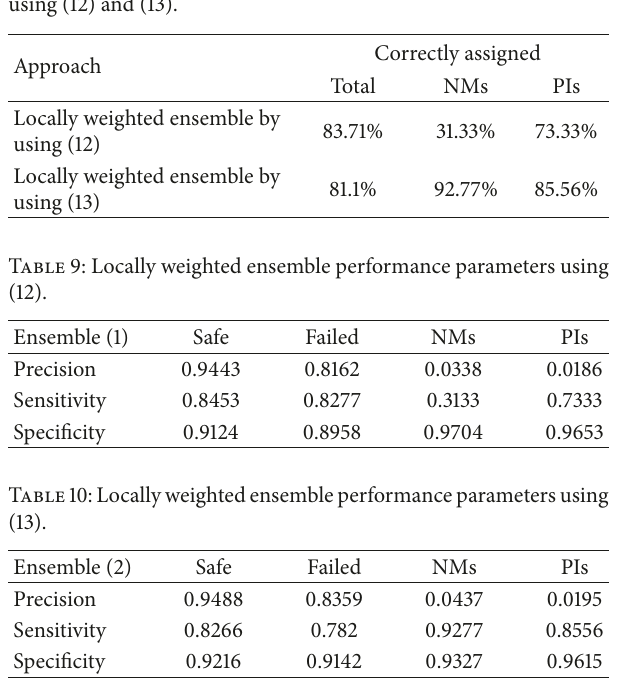
Table 11: Ensemble classification